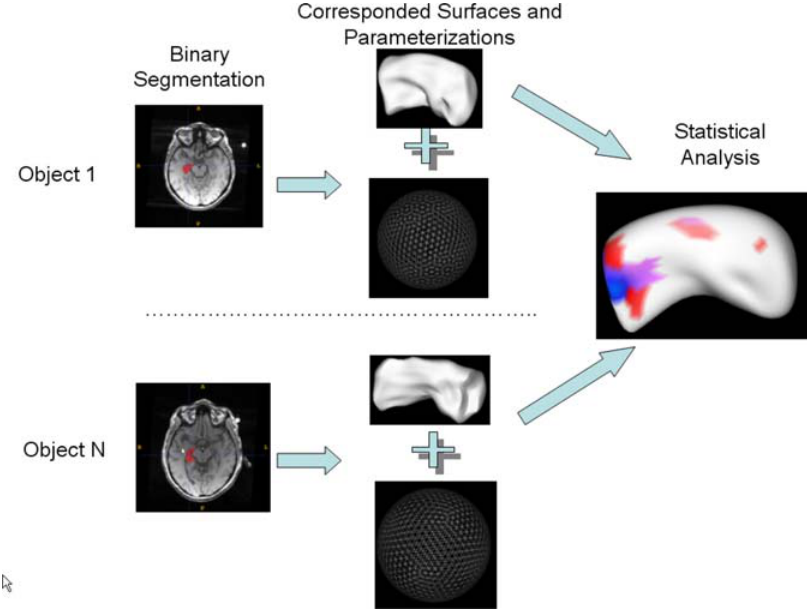
Figure 1. Shape analysis process.